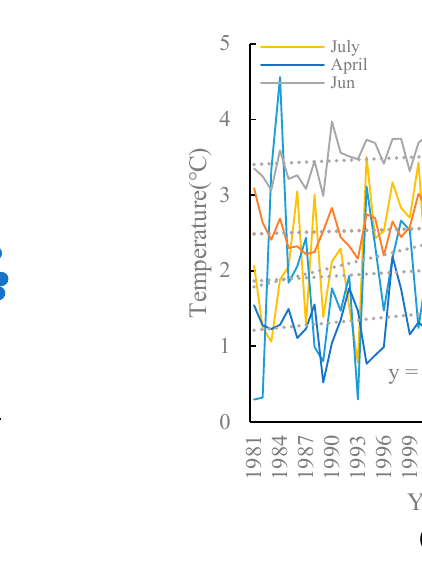
Figure 8. Detailed records of outburst date from Lake Merzbacher from 1902 to 2022 ( a ). Temperature changes in Lake Merzbacher from 1981 to 2022 ( b ).